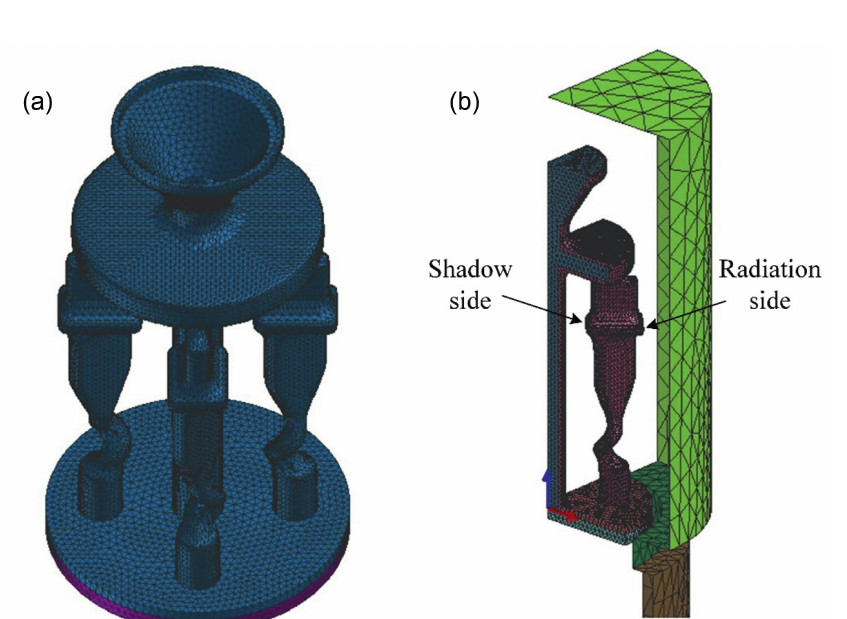
Figure 2: The constructing manner of mould cluster (a) A, (b) B and (c) C, with the deviation (assembling) angle of 0°, 45° and 90°, respectively.